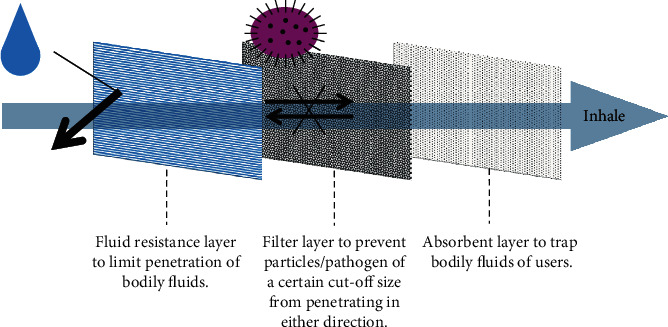
Illustration showing the function of each individual layers of a 3-ply surgical mask.